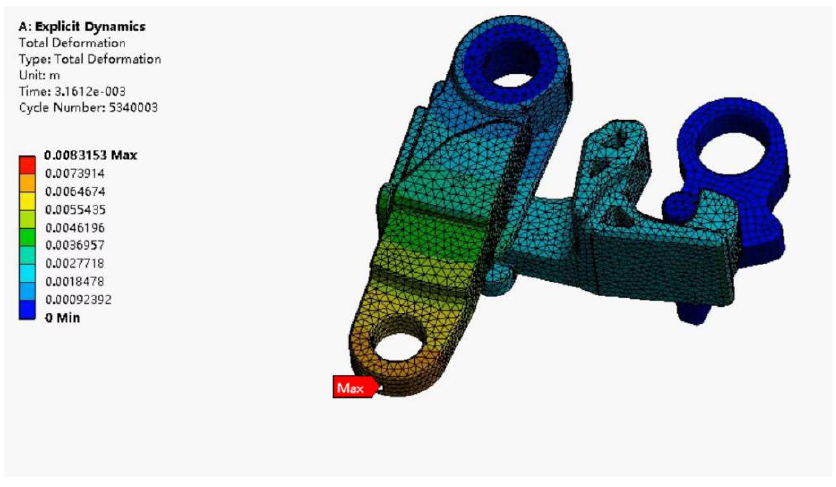
Figure 16. 5.5 N simulation results of motion end state.